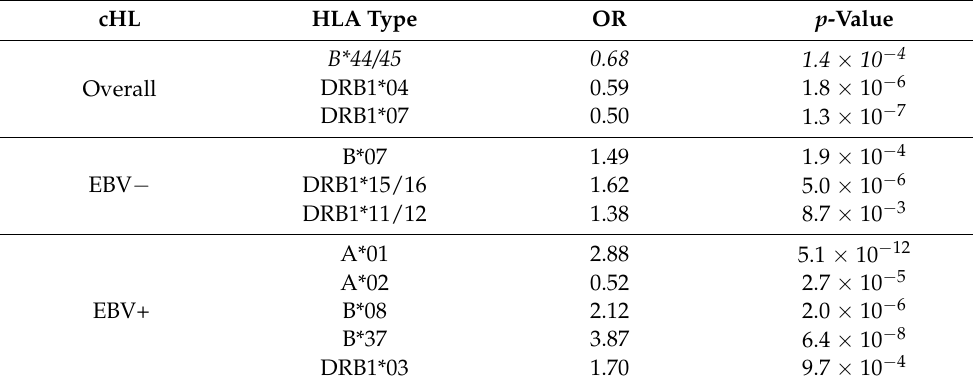
Table 2. Meta-analysis of cHL-associated HLA alleles.